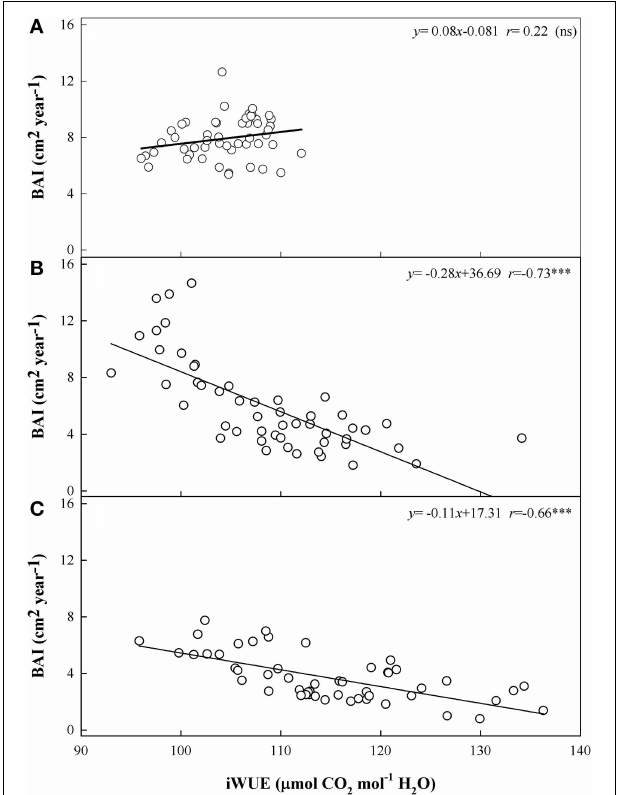
FIGURE 7 | Relationships between the basal area increment (BAI) and the intrinsic water use efficiency (iWUE) at the three sites from 1960 to 2010. (A) Site A1 (2700m a.s.l.), (B) Site A2 (2400m a.s.l.), and (C) Site A3 (2200m a.s.l.). Relationships between the two variables are calculated using Pearson’s correlation coefficient ( r ). Significance levels: *** , p < 0 . 001 ; ns, not